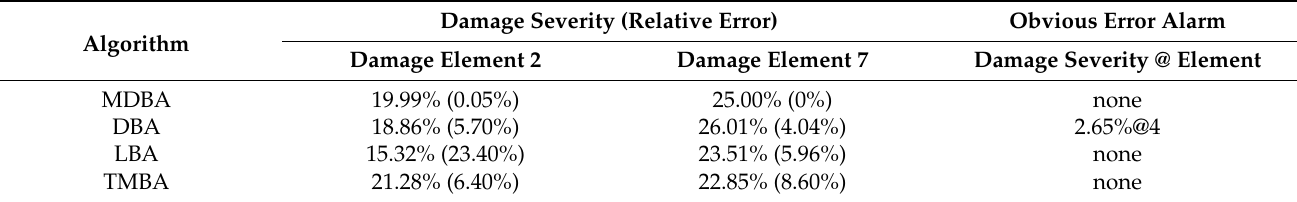
Table 3. The identification results of the damaged case by MDBA in different noise